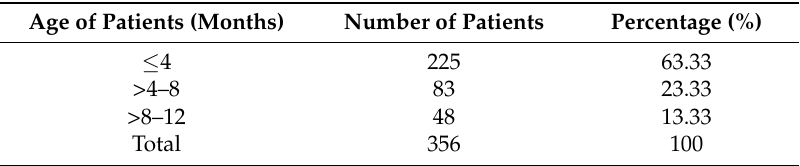
Table 1. Age distribution of patients.